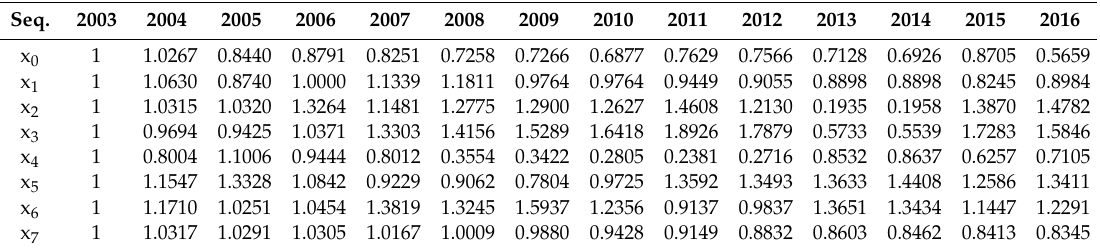
Table 5. Results of initial value treatment for Grey correlation analysis (2003–2016).